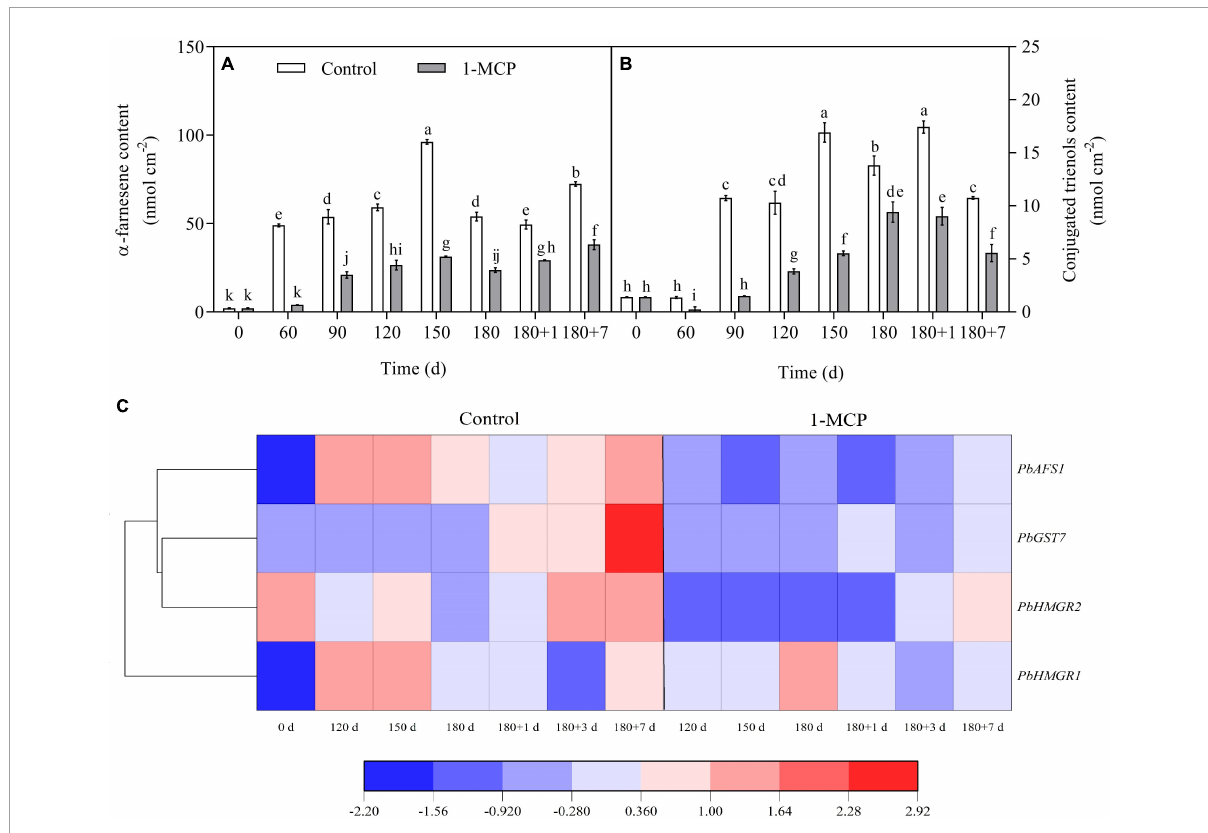
FIGURE4 Effect of 1-MCP on α -farnesene (A) and conjugated trienols (B) contents and related gene expression (C) of the peels in “Yali” pear. 180 + 1, 180 + 7 indicated Days 1, 7 at shelf life after 180 days of cold storage, respectively. All data are expressed as means ± standard errors of triplicate samples. Different letters indicate significant differences ( P < 0.05) by Duncan’s multiple comparison